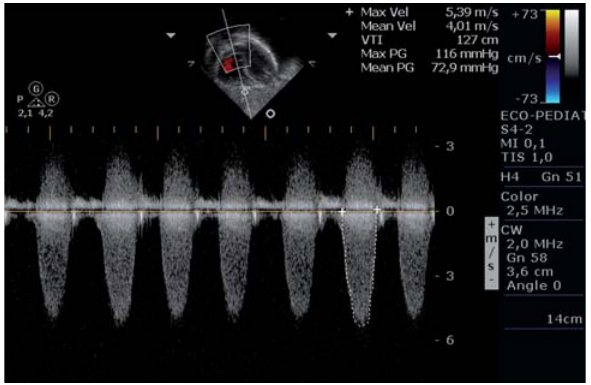
Fig. 4 – Doppler contínuo pré-operatório mensurando o gradiente no local da estenose supravalvar no tronco pulmonar